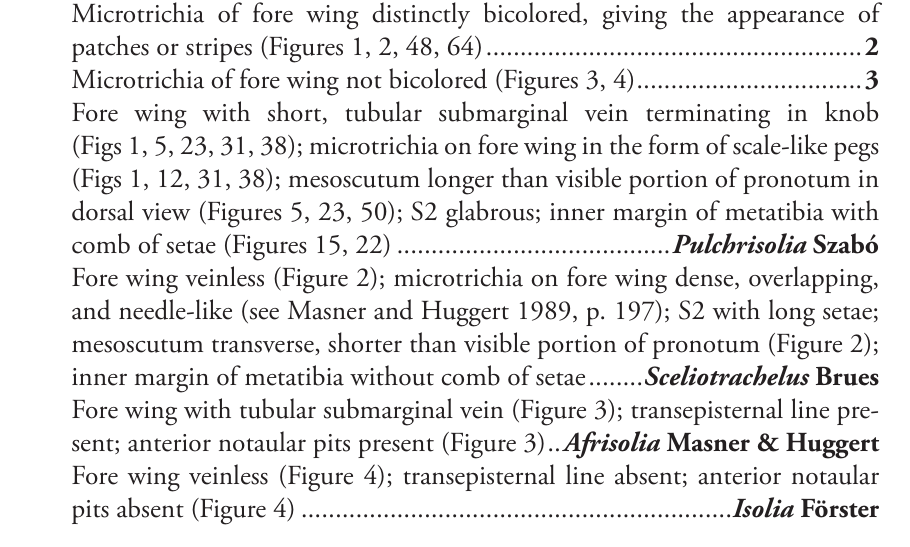
Key to species of Pulchrisolia (males and females) 1 Fore wing with one black band or a black band and a circular black area (Figs 8, 38); marginal cilia of female fore wing absent; costal margin of hind wing without dark, thick sclerotization posterior to hamuli; frontal ledge pre- sent or absent (Figures 5, 10, 21) ................................................................ 2 – Fore wing with two black bands (Figures 15, 20, 28); marginal cilia of female fore wing present or absent; costal margin of hind wing with dark, thick scleroti- zation posterior to hamuli; frontal ledge present (Figures 5, 14, 16, 19, 21) ..... 5 2 Frontal ledge absent (Figure 10) ........................ P. ankremos Lahey, sp. nov. – Frontal ledge present (Figures 14, 16, 30, 36, 51, 54) ................................. 3 3 Fore wing with a circular arrangement of black microtrichia (Figure 38); mes- oscutellum longitudinally striate (Figure 33) ...... P. nephelae Lahey, sp. nov. – Fore wing without circular pattern of black micotrichia (Figure 22); mesoscu- tellum smooth (Figures 12, 31) ................................................................... 4